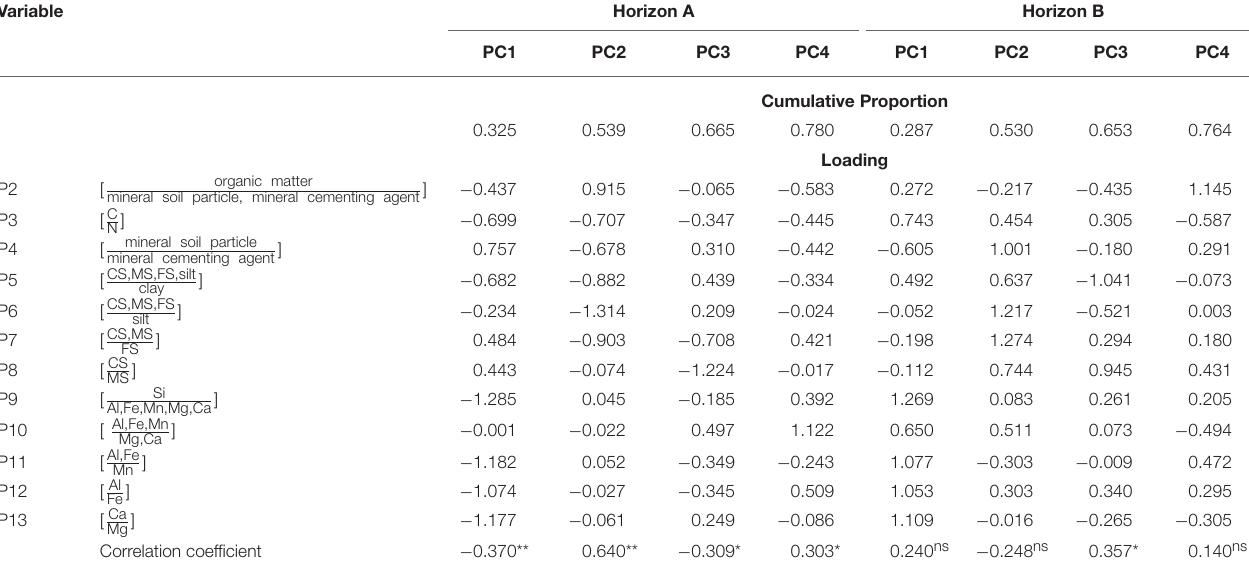
TABLE 3 | Principal component analysis and loadings for soil properties related to the critical water content.